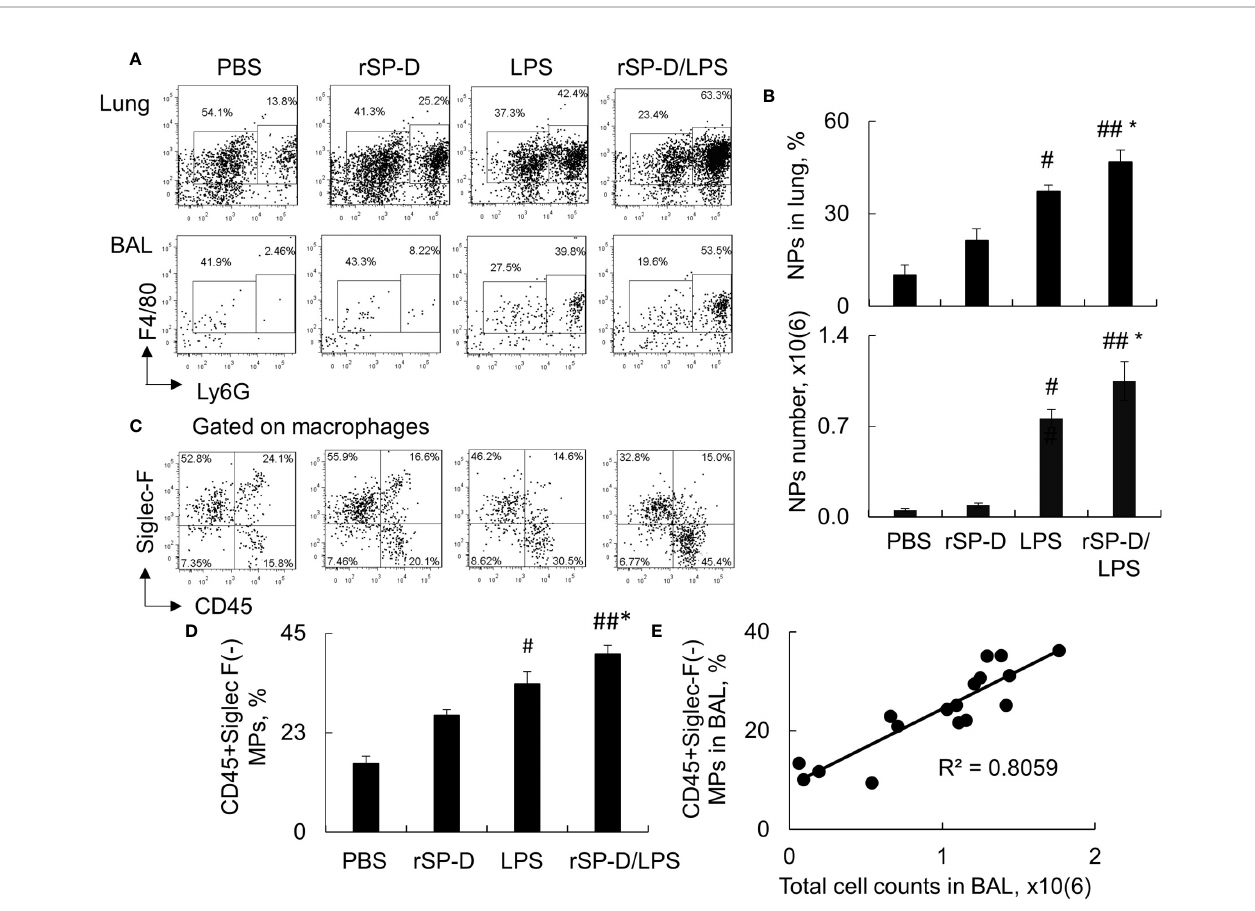
FIGURE 6 | Recombinant murine surfactant protein D (rSP-D) increased neutrophil in fi ltration and CD45+Siglec-F(-) M1 subtype macrophages in the lung of mice with acute lung injury (ALI). (A) Flow cytometry analysis for Ly6G+ neutrophils (NPs) and Ly6G(-) macrophages (MPs) in the lung digests and bronchoalveolar lavage (BAL) of treated mice. Representative dot plot was shown. (B) Quantitative analysis of the percentage and absolute number of NPs in the lung tissues and BAL, respectively. * p < 0.05 vs . lipopolysaccharide (LPS) group; # p < 0.05, ## p < 0.01 vs . phosphate buffered saline (PBS) group. (C) Flow cytometry analysis for CD45+Siglec-F(-) M1 and CD45+Siglec-F(+) M2 subtype MPs in BAL. Representative dot plot was gated on MP population. (D) Quantitative analysis of CD45+Siglec-F(-) subtype MPs in BAL. Data were presented as mean ± SE. *p < 0.05 vs . LPS group; # p < 0.05, ## p < 0.01 vs . PBS group. (E) Correlation analysis between CD45+Siglec-F(-) M1 subtype MPs and total cell counts in BAL. Each dot presents the value of an individual